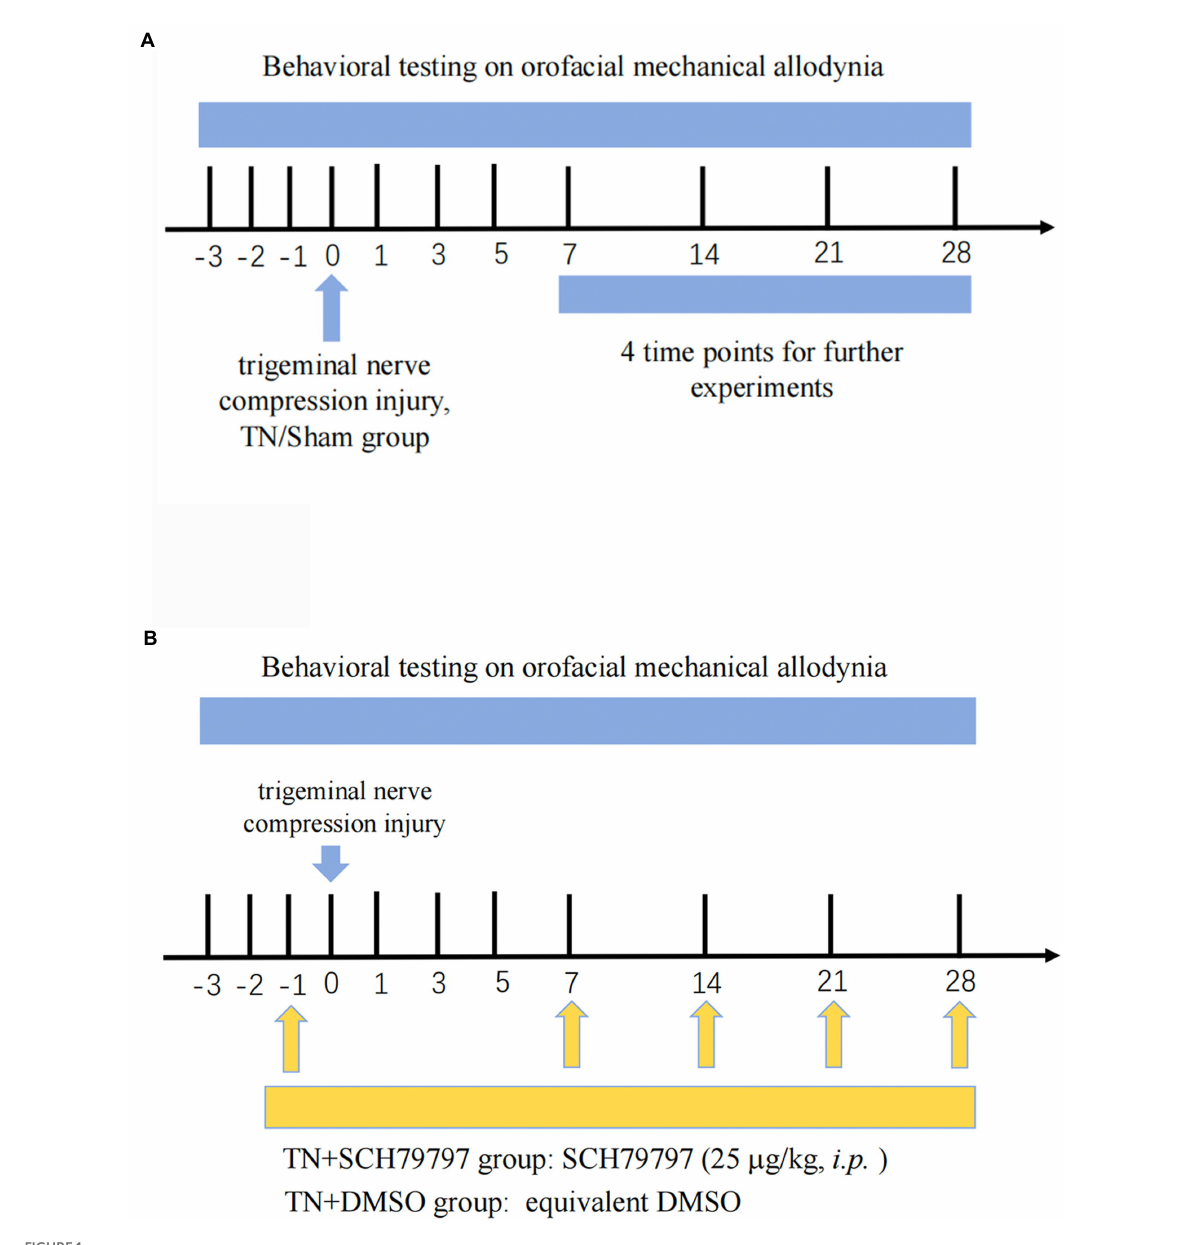
FIGURE 1 Study timeline. (A) Three days prior to the establishment of the TN model, all rats were adapted to the mechanical pain test environment, and the basal orofacial mechanical threshold was tested. Rats randomly received either trigeminal compression injury or sham injury. On PODs 7, 14, 21, and 28, behavioral testing was conducted. Then, the rats were euthanized, and tissues were collected for analysis of BNB integrity, coagulation system-related tests, and structural observation of the nodes of Ranvier. (B) Rats underwent the same orofacial mechanical threshold tests. On the day before surgery, the rats randomly received either an intraperitoneal injection of SCH79797 or DMSO. On PODs 7, 14, and 21, rats in the TN + SCH7979 group received SCH7979, while rats in the TN + DMSO group were injected with the same volume of